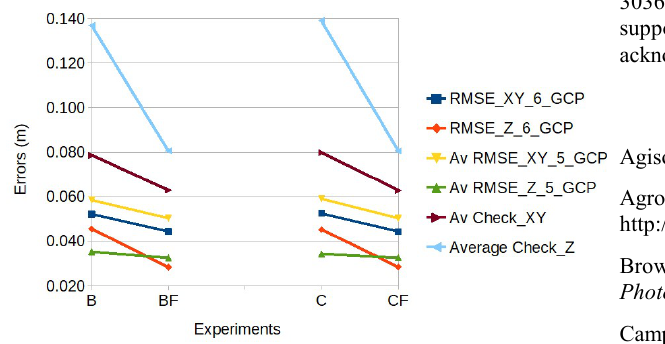
Figure 10. Errors in ground coordinates when using the estimated sets of